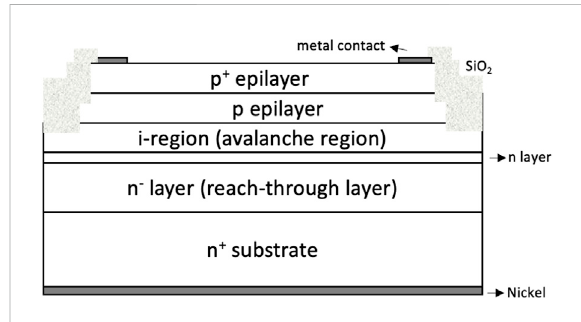
FIGURE 6 Schematic view of a typical APD structure [80]. The reported example is made up of a n + substrate, a n − 2 μ m thick reach- through layer (used to increase the quantum ef fi ciency of penetrating UV light), a 0.11 μ m n layer, a 0.2 μ m intrinsic- region (avalance region), a 0.25 μ m p layer, and a 0.2 μ m p +